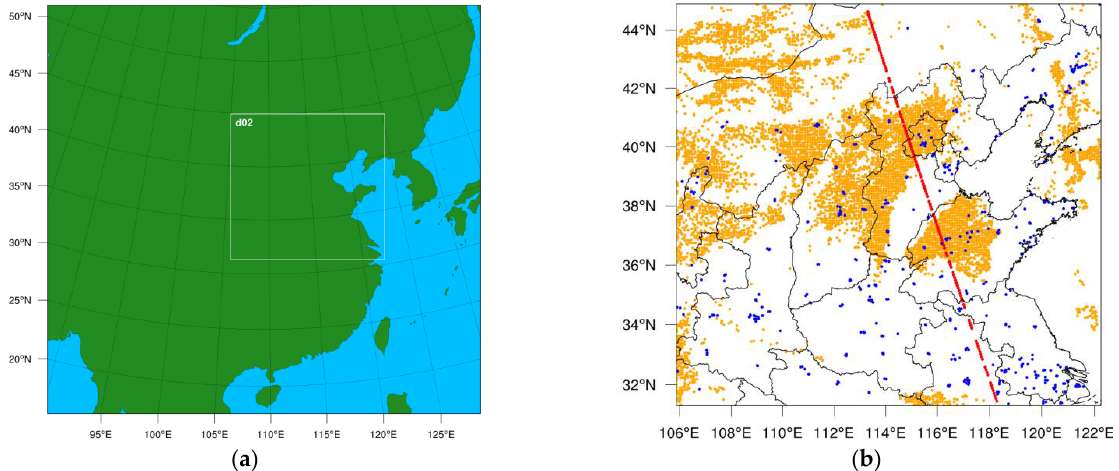
Figure 1. ( a ) double-nested experimental domain. ( b ) Spatial distribution of PM 2.5 data (blue point) in d02, CALIPSO AEC data (orange point), and AOD data (red point).